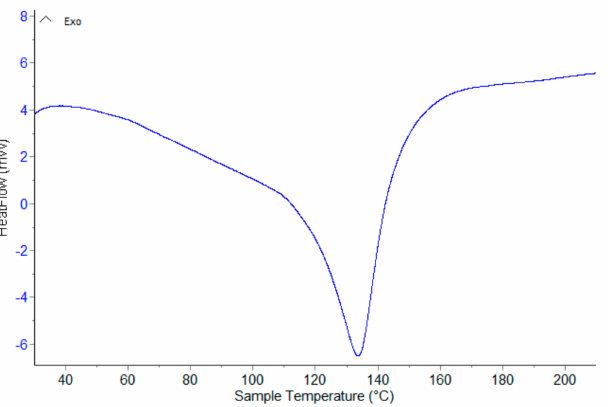
Figure A2. The DSC thermogram of β -CD, dynamic nitrogen atmosphere, β = 10 K min − 1 .